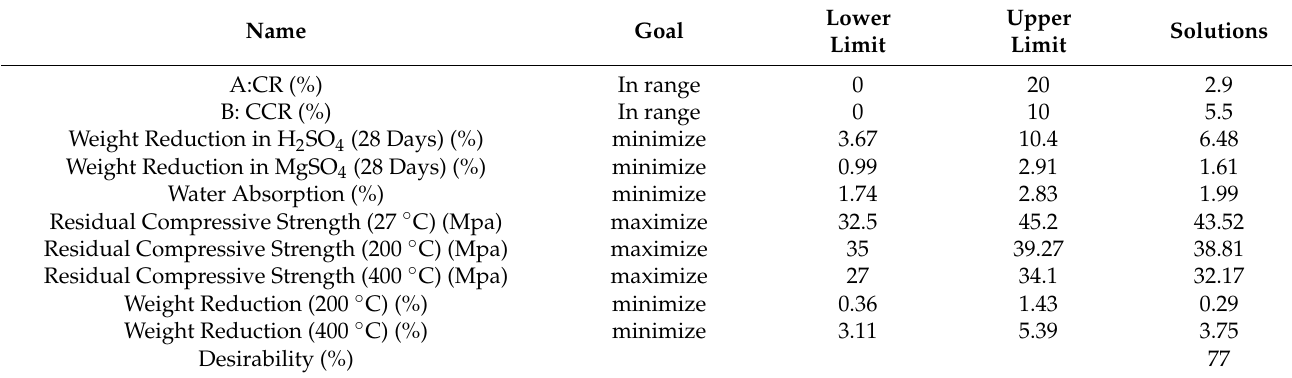
Table 11. Optimization criteria and